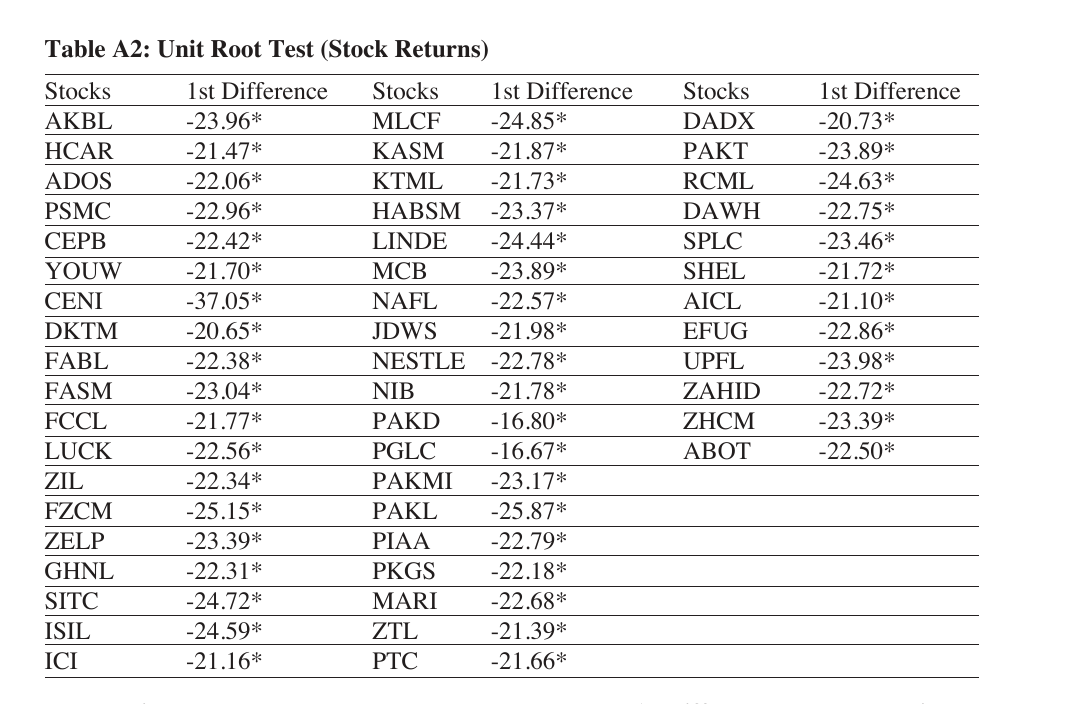
Note: Unit Root test conducted on level at trend and on 1st difference at trend and inter- cept. (The table 2 reports the results of the stocks that have become stationary on 1st difference at trend and